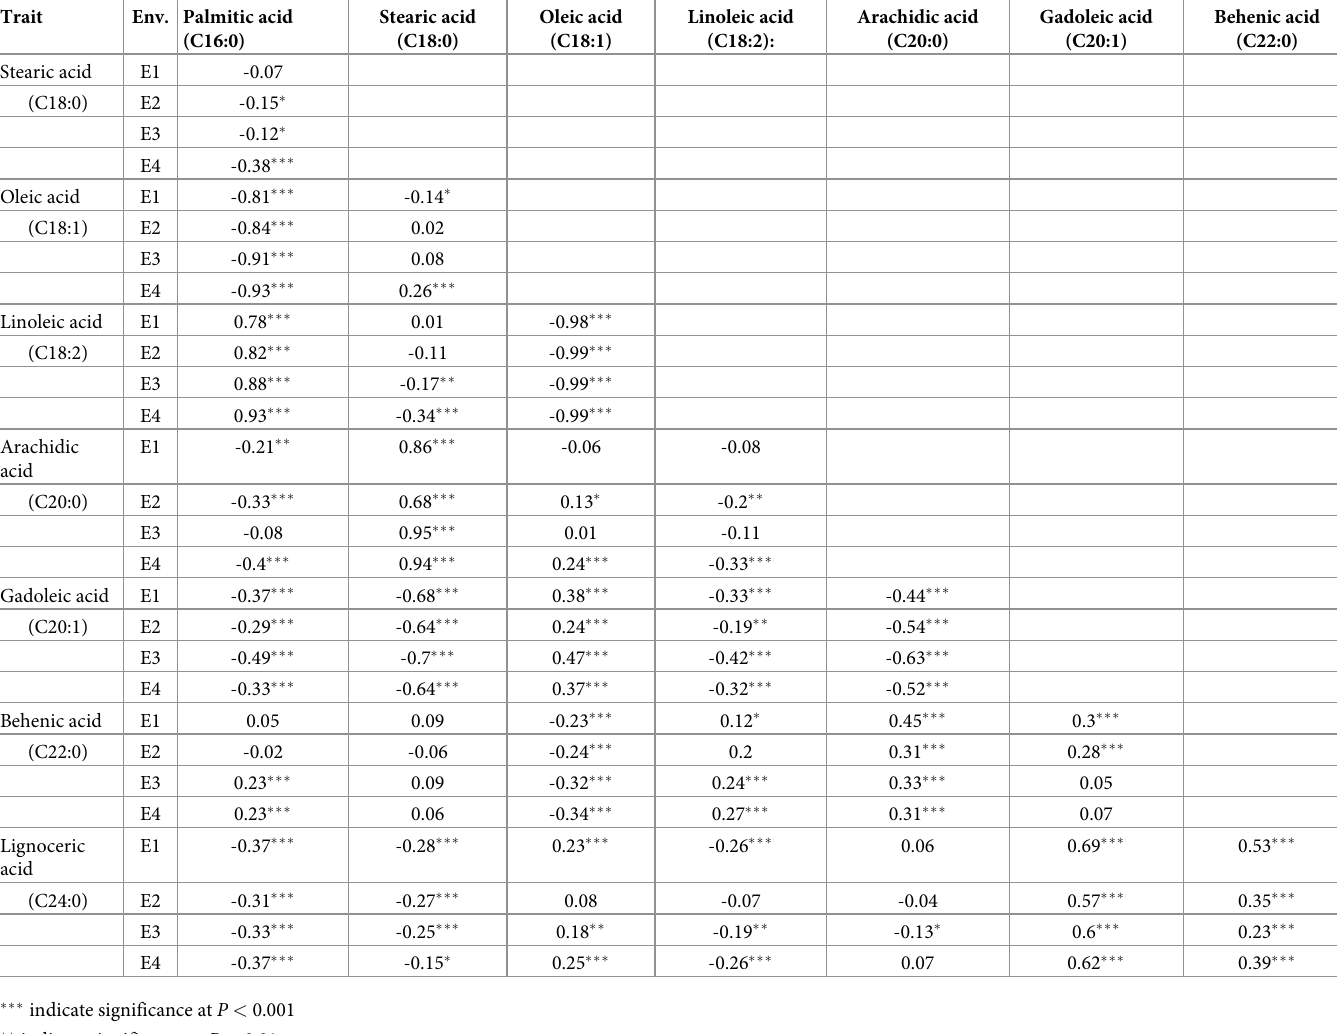
Table 2. Correlation matrix among fatty acid components across four environments.